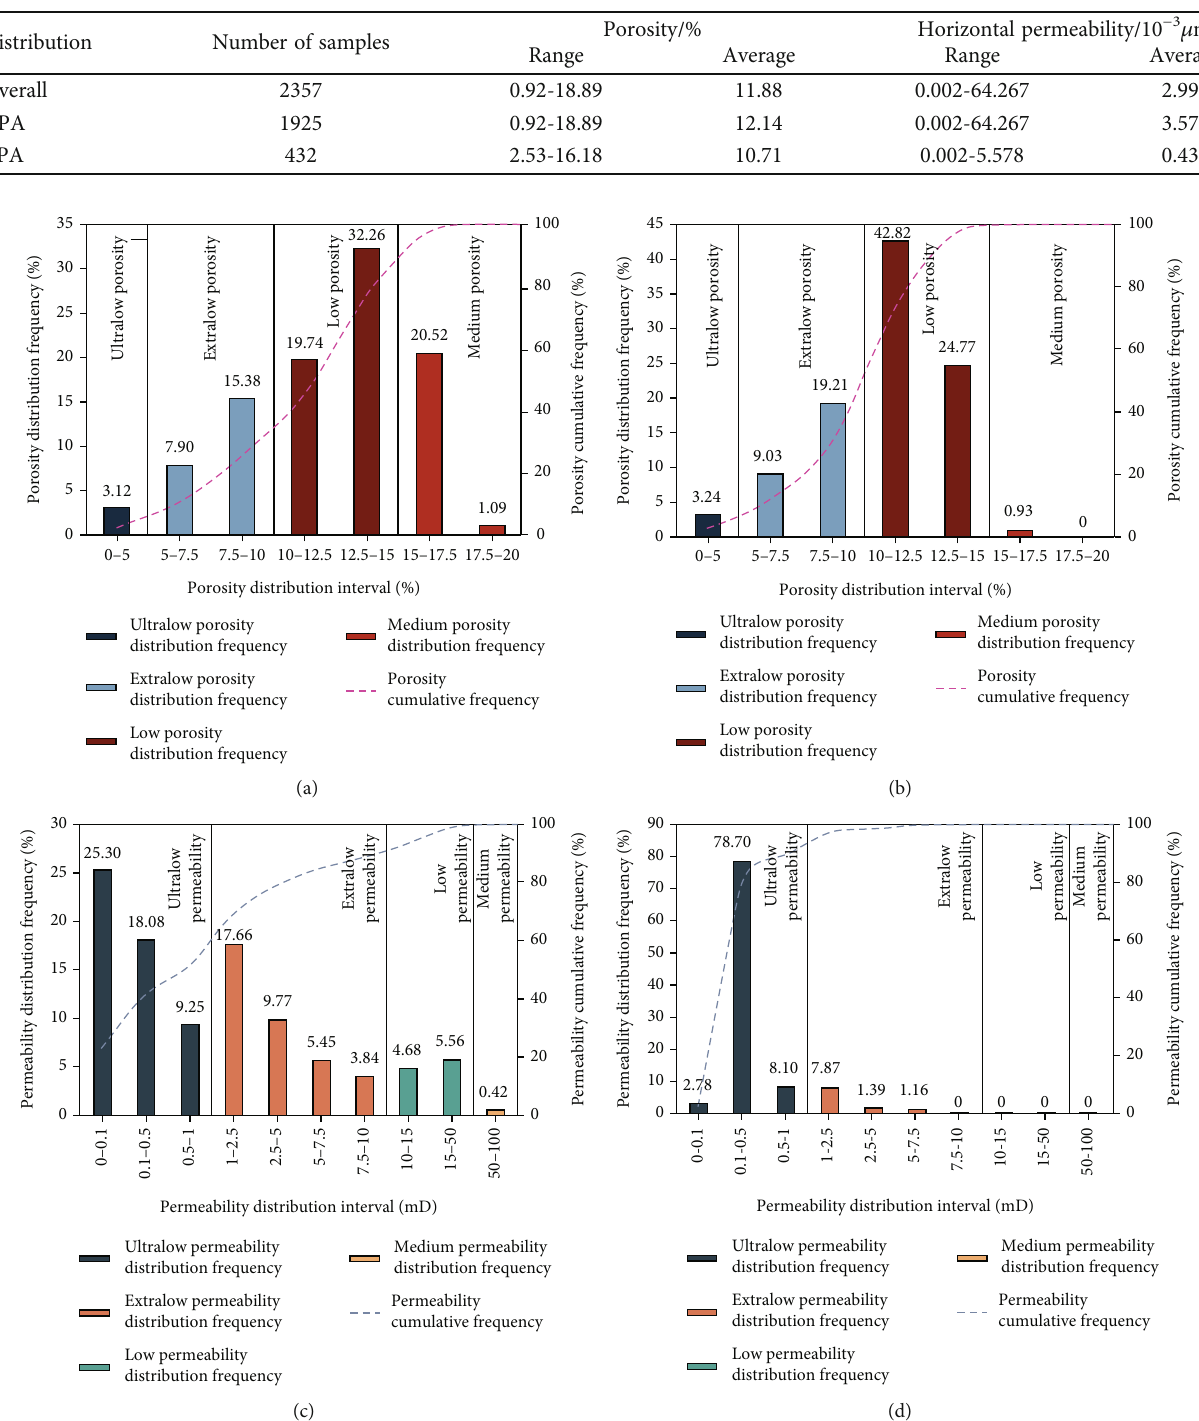
reservoir. (a) Distribution characteristics 2